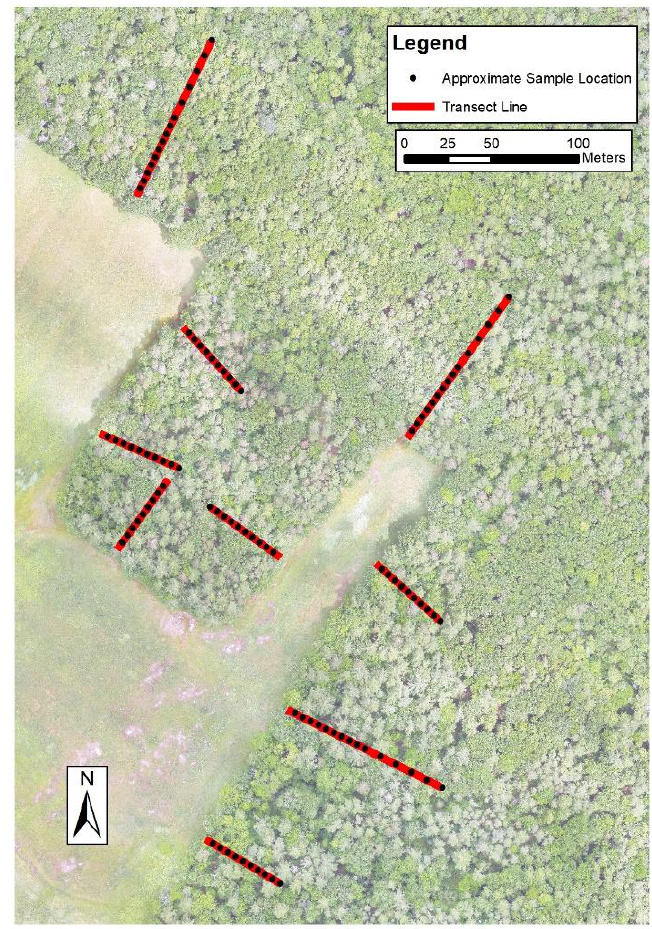
Figure 4. Estimated location of transects (red lines) and sample points (black dots) along each transect measured on the ground. Locations for transects were based on GPS position of 0 m point and azimuth bearing of the transect. Sample locations were systematically placed on transect line starting at 5 m and extending to either 50 or 100 m. See Figure 2 for sample spacing.